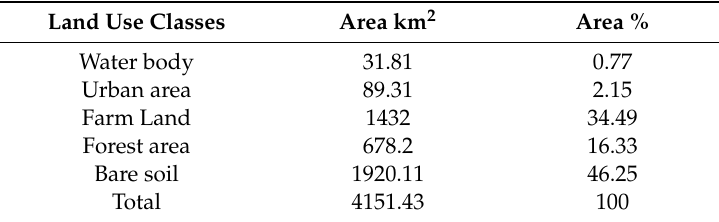
Table 1. The area covered by the di ff erent land use land cover